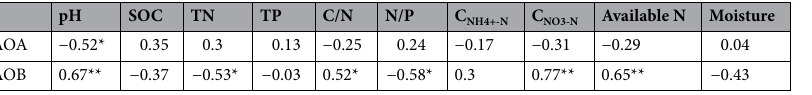
Table 2. Correlation analysis between soil physicochemical properties and abundance of ammonia-oxidizing microorganisms. *Significant correlations at 0.05 level. **Significant correlations at 0.01 level. Dates mean the relation coefficient.